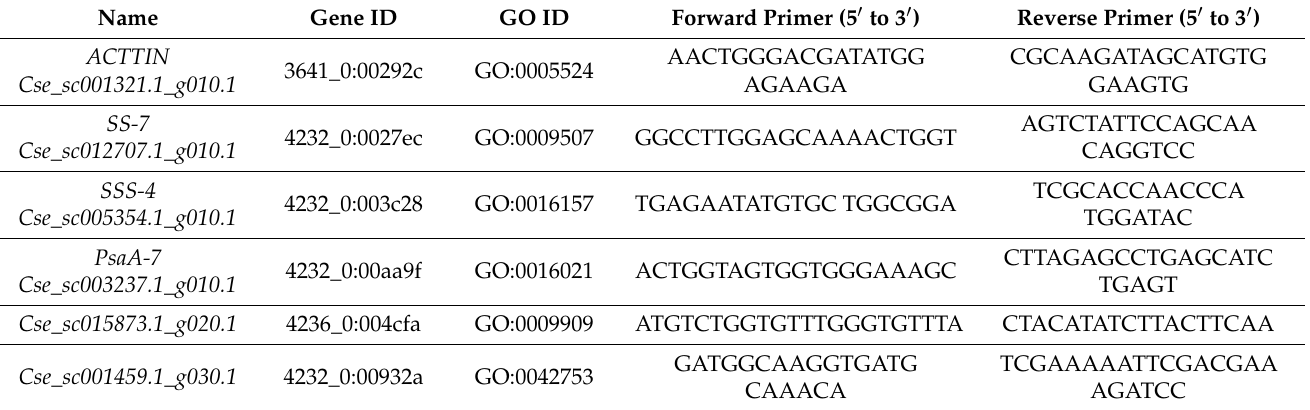
Table 5. List of the primers used to quantify the gene expression